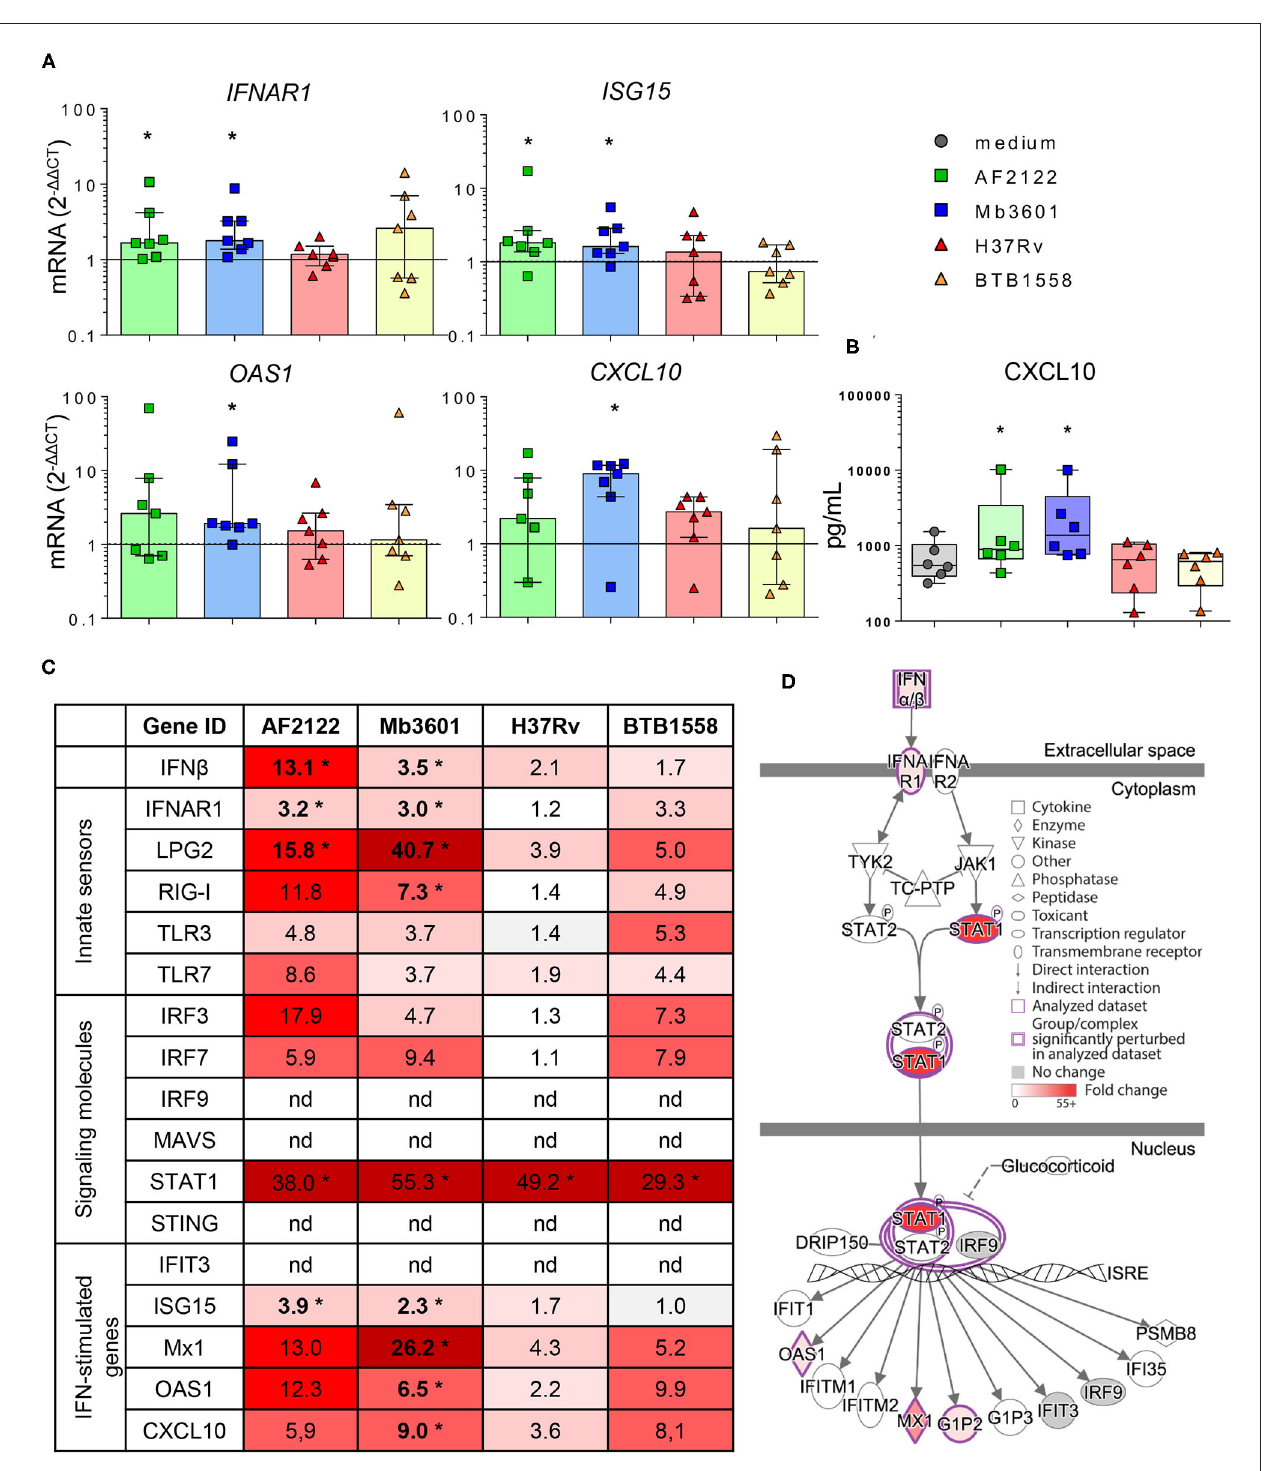
FIGURE 5 | Mb but not Mtb infection in the lung tissue from Blonde d’Aquitaine cows induces the type I interferon pathway. The precision-cut lung slice (PCLS) was infected as described in Figure 1 . (A) IFNAR , ISG15 , CXCL10 , and OAS1 gene expression at 2 dpi. Individual data and the median and interquartile range in each group are presented ( n = 7). (B) CXCL10 protein level was measured in PCLS supernatant at 2 dpi. Individual data and the median and interquartile range in each group are presented ( n = 6). (C) The table represents the mean of fold change (2 − dCT ) for each group ( n = 7) of major genes involved in type I interferon pathway. The graduated red box coloring is for higher gene expression, and the asterisks mark significant differences compared to uninfected PCLS. nd, not detected. (D) Ingenuity pathway analysis drawing of the type I interferon pathway under IFNAR in the Mb3601 group. The graduated red box coloring is for higher gene expression. (A–C) * p < 0.05 (Wilcoxon nonparametric